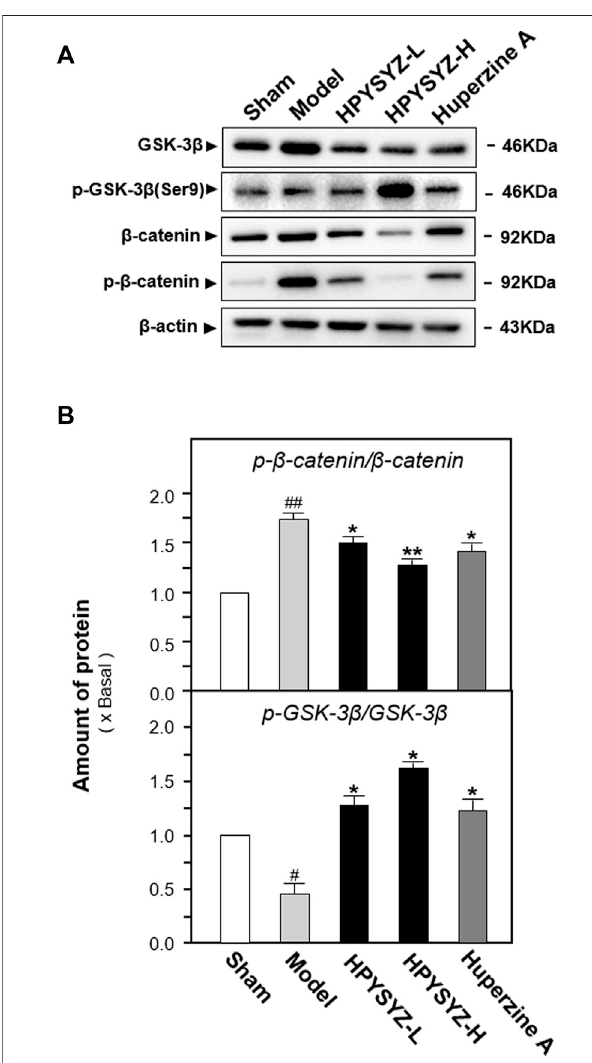
FIGURE 5 | Ethyl acetate extracts of succinum regulated the GSK3 β / β - catenin signaling pathway in the hippocampus of carotid artery ligation rats. (A) Effects of ethyl acetate extracts of succinum at low dosage (HPYSYZ-L) and high dosage (HPYSYZ-H) on the expressions of GSK3 β , p-GSK3 β (Ser9), β -catenin, p- β -catenin, and β -actin of hippocampus of carotid artery ligation rats were evaluated by Western blotting analysis. The representative images are displayed ( n = 5). (B) Expression ratio of p- β -catenin to β -catenin was calculated, and the expression of β -actin was applied for normalization. Expression ratio of p-GSK3 β (Ser9) to GSK3 β was calculated, and the expression of β -actin was applied for normalization. Values are expressed as the percentage of the control group (no drug treatment normal mice) as mean ± SEM ( n = 5). Comparisons between groups were analyzed by a one- way ANOVA followed by a post hoc Bonferroni test. ## p < 0.01 (compared with the control group), * p < 0.05, and ** p < 0.05 (compared with the model group). to β -catenin was increased in the hippocampus compared with the sham group ( p < 0.01). Compared with model group rats, treatment of ethyl acetate extracts of succinum at two dosages both upregulated the expression ratio of p-GSK3 β to GSK3 β while downregulated the ratio of p- β -catenin to β -catenin